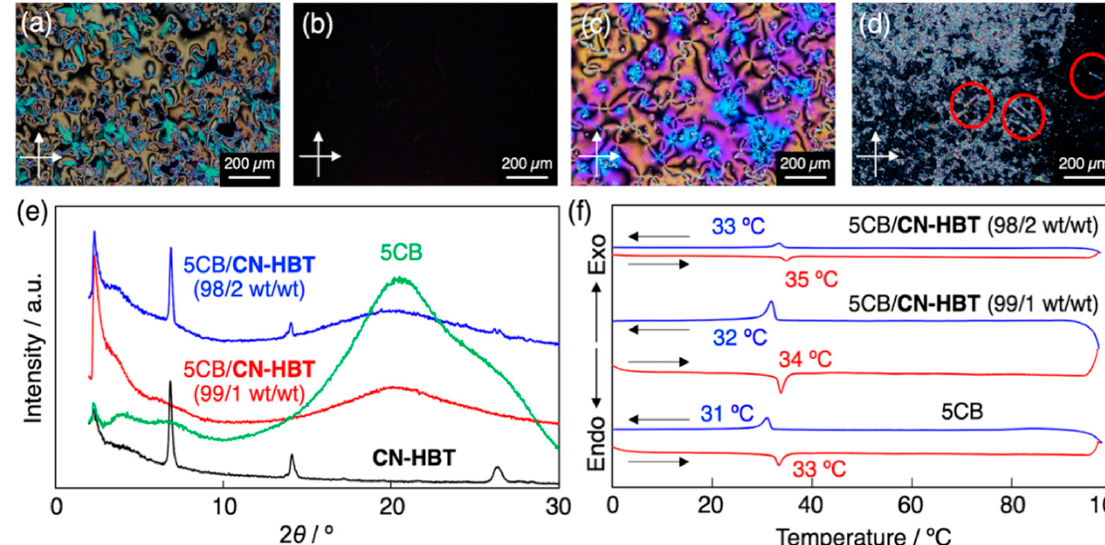
Figure 4. Cross-polarized optical microscopy images of ( a , b ) 5CB/ CN-HBT (99/1 wt/wt) at ( a ) 25 ◦ C and ( b ) 40 ◦ C, ( c ) PCH5/ CN-HBT (0.5/99.5 wt/wt) at 25 ◦ C, and ( d ) 5CB/ CN-HBT (98/2 wt/wt) at 25 ◦ C in a glass sandwiched cell. Red circles represent needle-shaped microcrystals. ( e ) XRD patterns of CN-HBT (black), 5CB (green), 5CB/ CN-HBT (99/1 wt/wt) (red), and 5CB/ CN-HBT (98/2 wt/wt) (blue). The incident X-ray wavelength was λ = 1.54 Å. ( f ) DSC traces of 5CB and 5CB/ CN-HBT (99/1 and 98/2, wt/wt) on 1st cooling (blue), and 2nd heating (red) at 10 K min –1 .